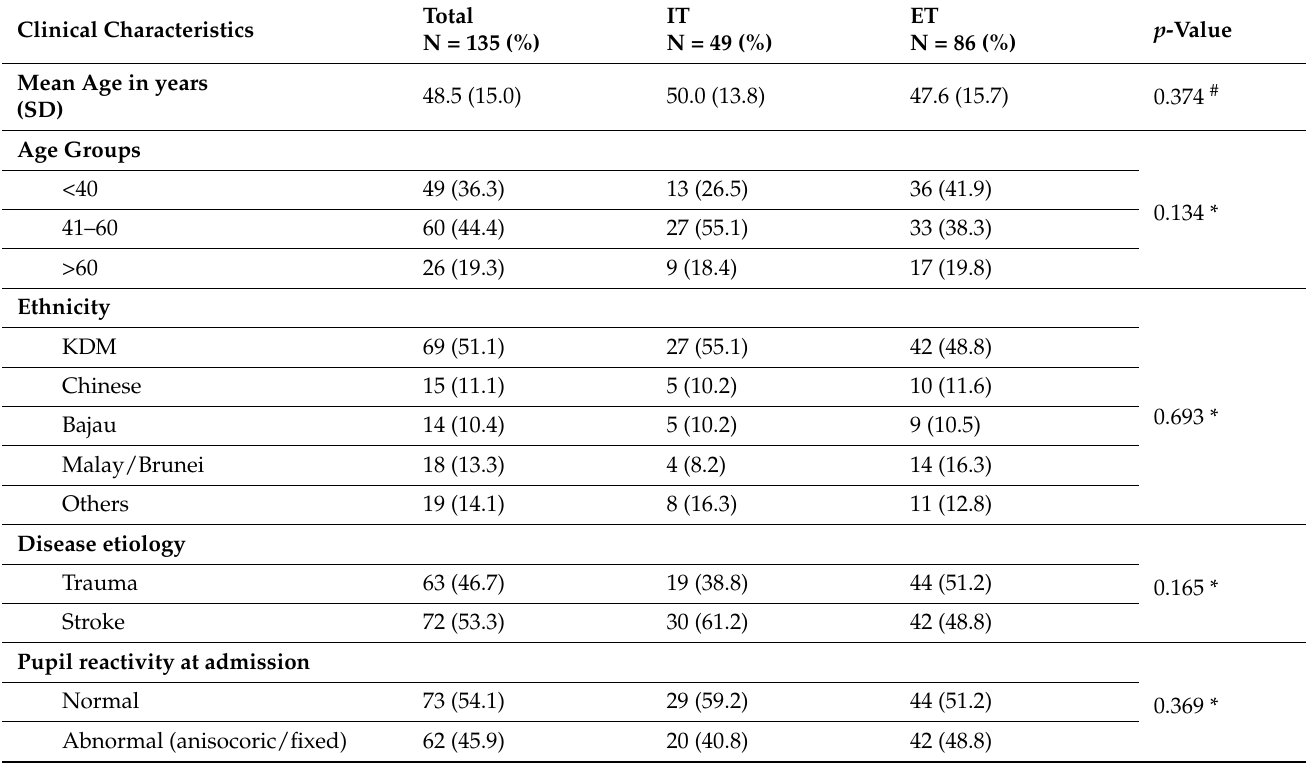
Table 1. Comparison of baseline clinical characteristics between Immediate Tracheostomy (IT) and Early Tracheostomy (ET) after decompressive craniectomy